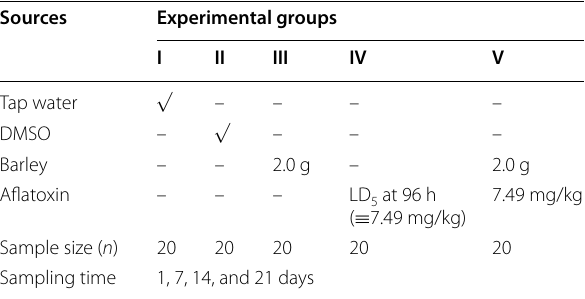
Table 1 Experimental design for the subacute experimentation Sources Experimental groups